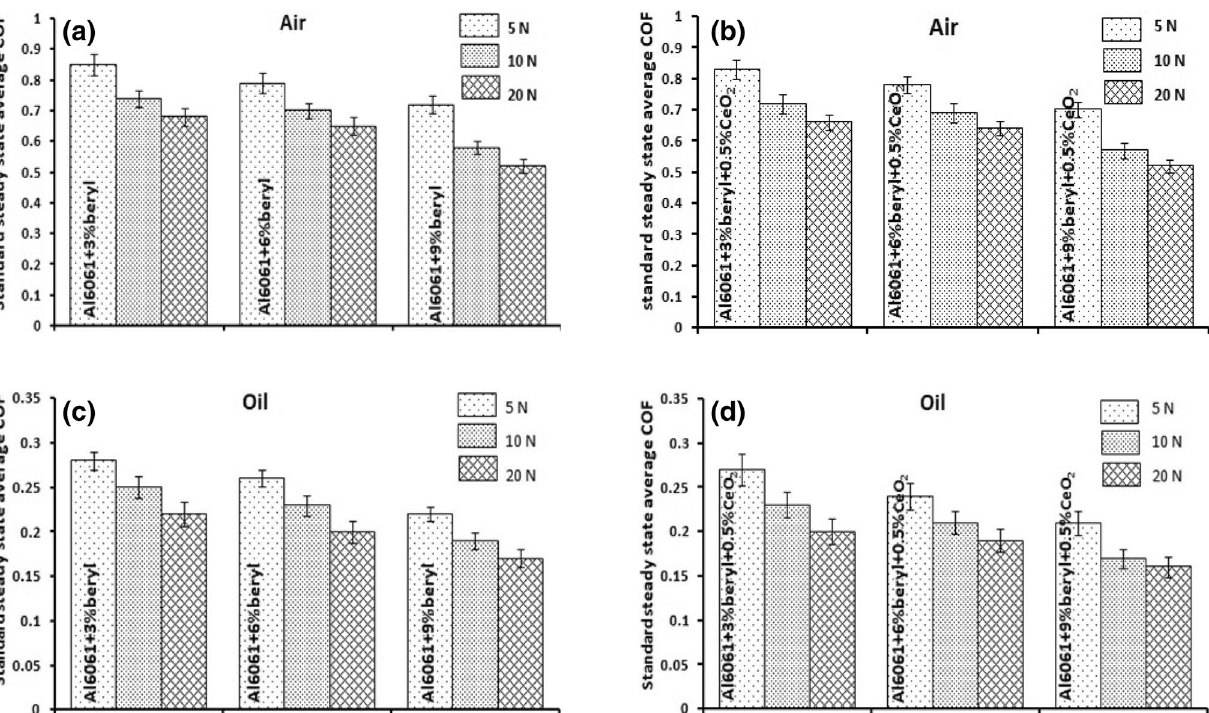
Fig. 7 Representative wear track of “Al6061–9% Beryl–0.5% CeO composites in air under load of 20